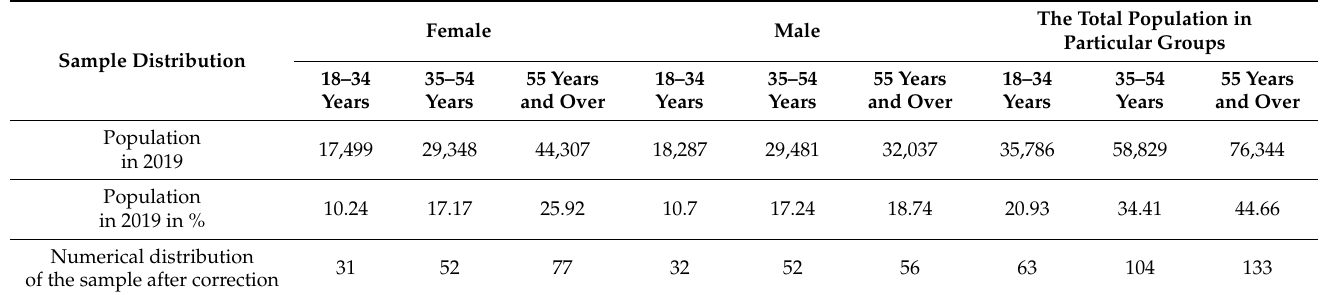
Table 1. Distribution of the sample of adult residents of Sosnowiec by sex and age (source: the authors, based on the Central Statistical Office Poland, Local Data Bank